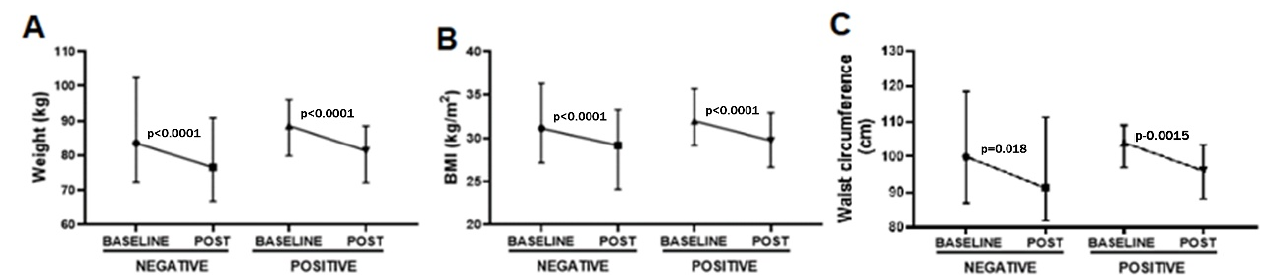
Figure 6. Representation of variation in weight (kg, ( A )), BMI (kg/m 2 , ( B )), and waist circumference (cm, ( C )), presented as the mean and SD, of all the volunteers enrolled in the present study separated into two different groups according to the presence (POSITIVE) or absence (NEGATIVE) of urinary ketone bodies, both before (BASELINE) and after (POST) 4 Phases Methodology application.